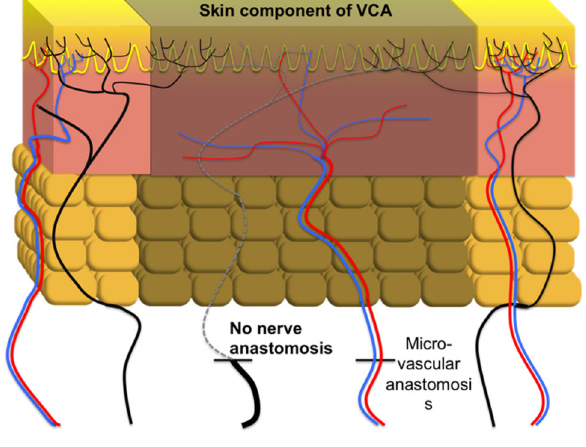
Figure 6. Schematic diagram of a denervated ostemyocutaneous flap. Blood vessels are anastomosed without apposition of nerve endings allowing the regenerative pathway to undergo atrophy (Dotted line). Re-innervation of the denervated VCA epidermis is achieved through collateral sprouting of uninjured axons outside the transplant region (shown in